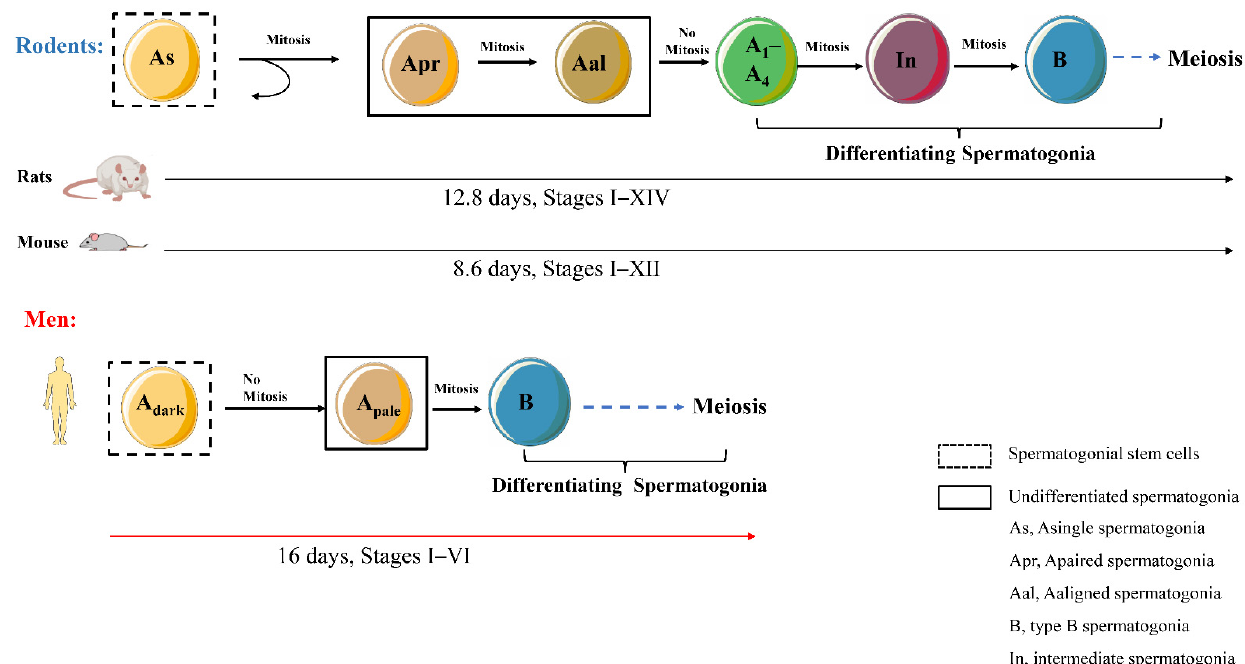
Figure 2. The cell division and seminiferous epithelial cycle of spermatogenesis in rodents and men. In testes of rodents, an As spermatogonia can produce two Apr cells spermatogonia through mitosis, then divide into Aal spermatogonia. As spermatogonia is referred as spermatogonial stem cells, and Apr and Aal spermatogonia are considered as undifferentiated cells. Aal spermatogonia transform into A1 spermatogonia without mitosis. A1 spermatogonia divide into Intermediate and B spermatogonia, subsequently, meiosis begins. It takes 12.8 days to complete a seminiferous epithelial cycle through 14 stages in rats, and 12 stages could be finished with 8.6 days in mouse testes seminiferous tubule. Adark spermatogonia are replicated to produce Apale spermatogonia, and then form type B spermatogonia which enter meiosis process in men. A cycle with 6 stages of the seminiferous epithelial is completed in 16 days in men.